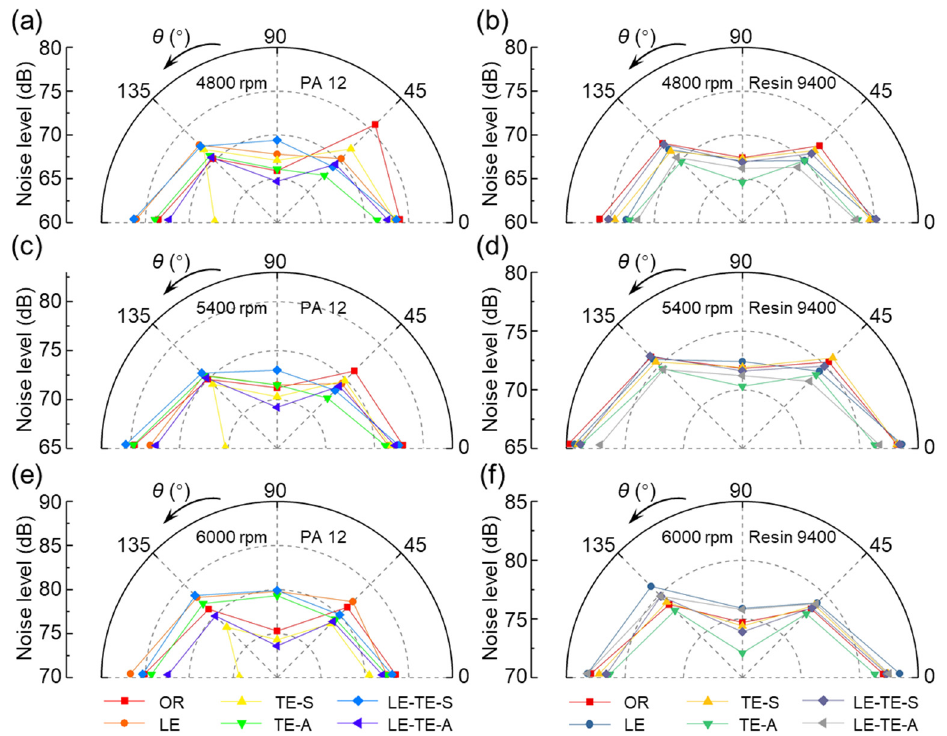
Figure 14. Noise directivity distribution of different rotors at 4800–6000 rpm. ( a , c , e ) Rotors with PA 12 at 4800 rpm, 5400 rpm, and 6000 rpm. ( b , d , f ) Rotors with Resin 9400 at 4800 rpm, 5400 rpm, and 6000